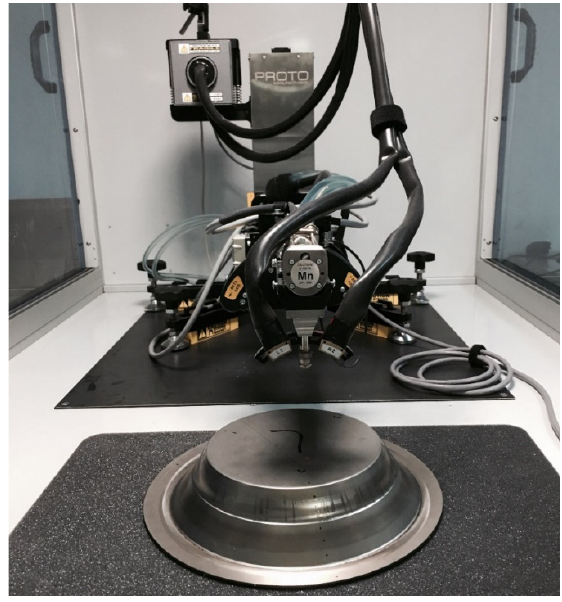
Figure 14. Residual stress testing process.